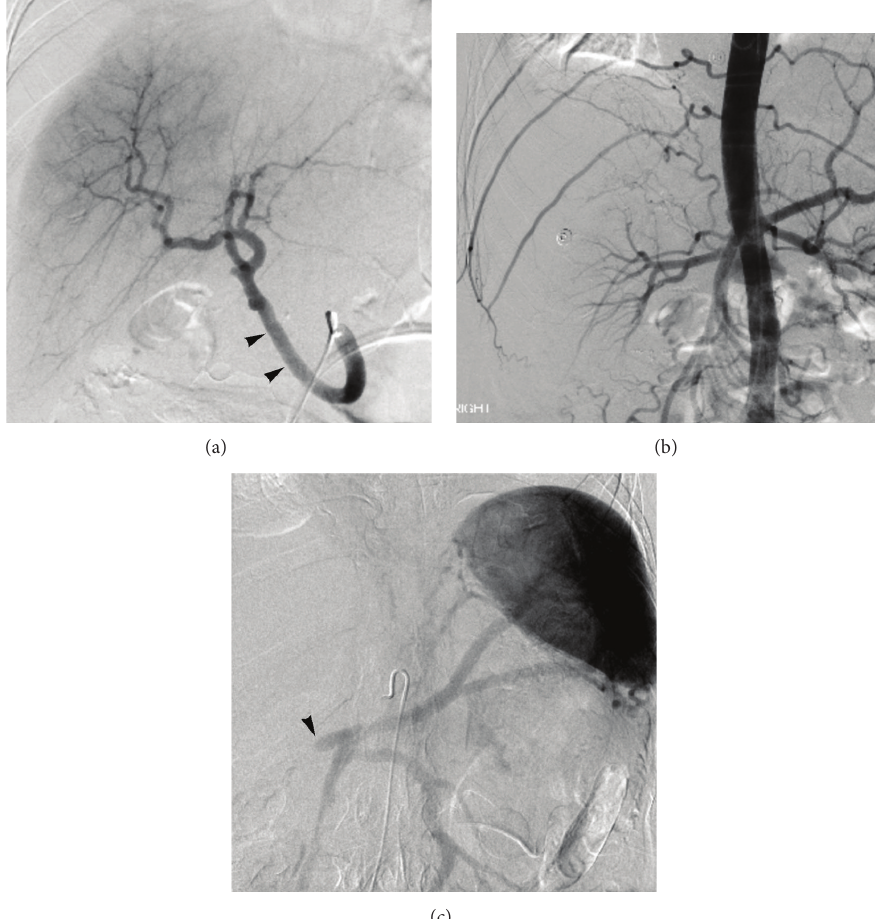
Figure 1: Digital subtraction angiogram (DSA) (a) shows patent iliac artery to hepatic artery graft (arrowheads). Digital subtraction aorta gram (b) demonstrates lack of iliac artery to hepatic artery graft opacification, indicating occlusion. Delayed venous phase imaging (c) reveals concurrent proximal portal vein occlusion